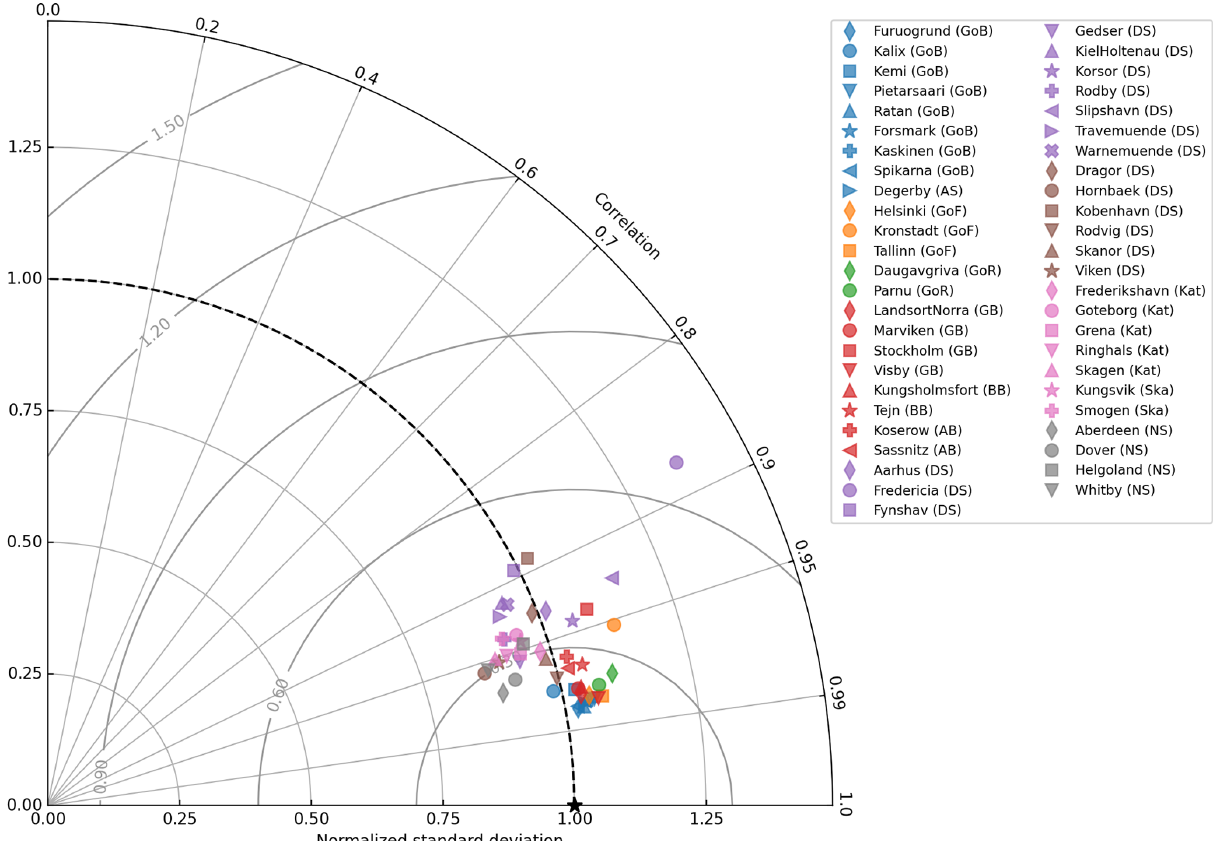
Figure 3. Taylor diagram of sea surface height error metrics. The metrics have been normalized by the standard deviation of the observations. See Fig. 1 for station locations; the sub-basin abbreviations are as in Fig. 2. NS stands for the North